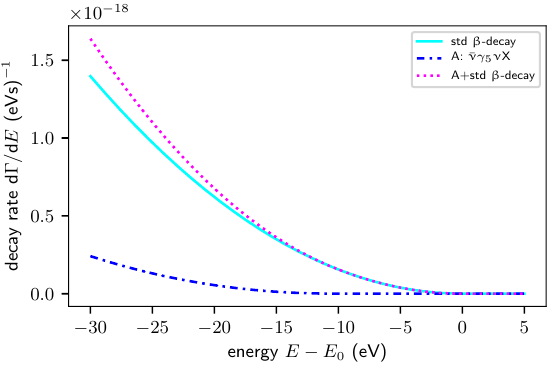
Figure 5 . Combination with standard b -decay. Shown is the signature of a light boson of type A with g X = 5 , m X = 10 eV together with standard b -decay spectrum with vanishing neutrino